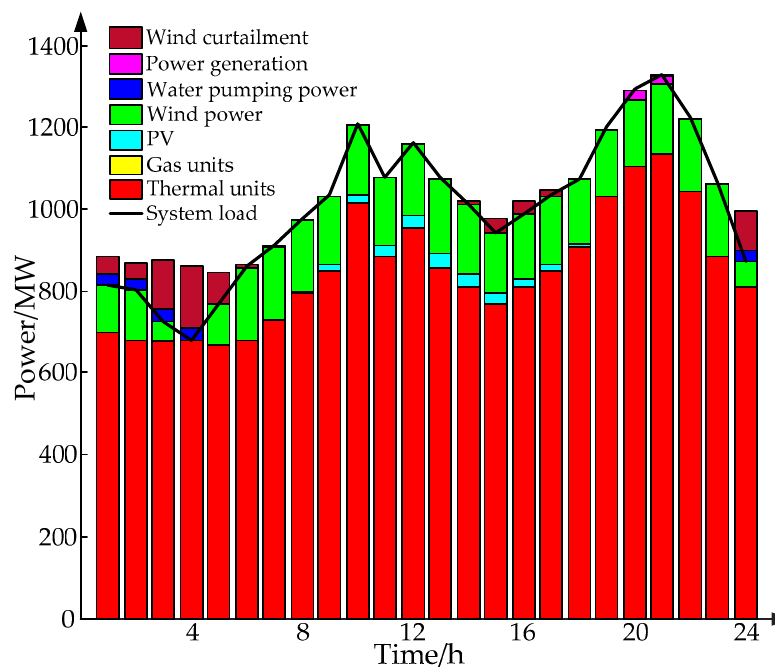
Figure 12. Output of each power source under WP continuous high output condition.